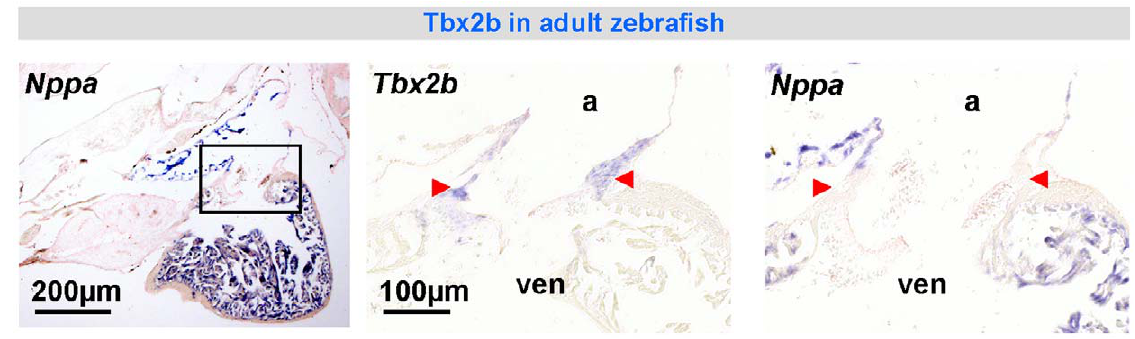
Figure 6. Tbx2 expression in the atrioventricular canal of the formed heart of the zebrafish ( in-situ hybridization). Nppa is expressed in a complementary pattern. a, atrium; ven, ventricle.